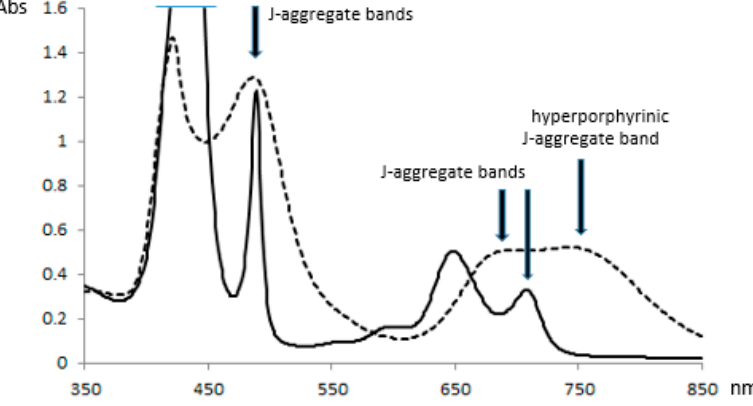
Figure 1. UV-vis spectra of 1 (continuous line; c = 2.0 × 10 − 4 M) and of its synthetic precursor 2 (dashed line; c = 1.8 × 10 − 5 M) in water at pH = 4.0 (acetic acid/sodium acetate buffer 0.1 M), cell path = 1